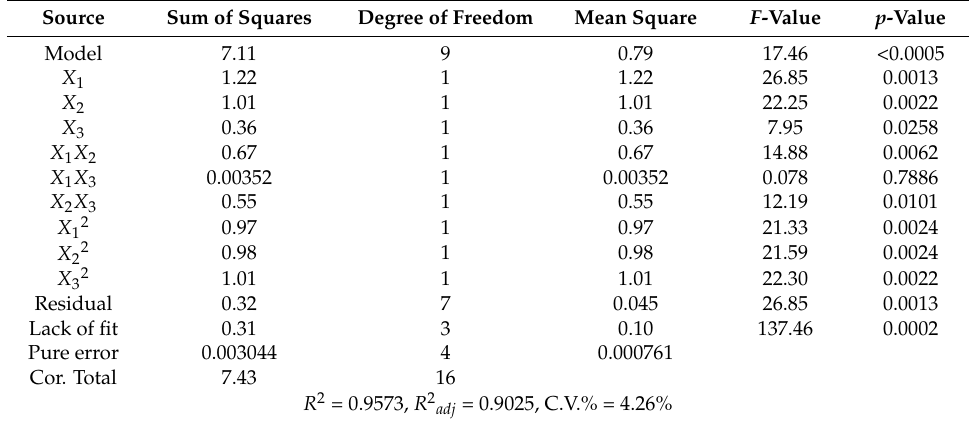
Table 2. Analysis of variance (ANOVA) for the fitted quadratic polynomial model of SJP extraction. Source Sum of Squares Degree of Freedom Mean